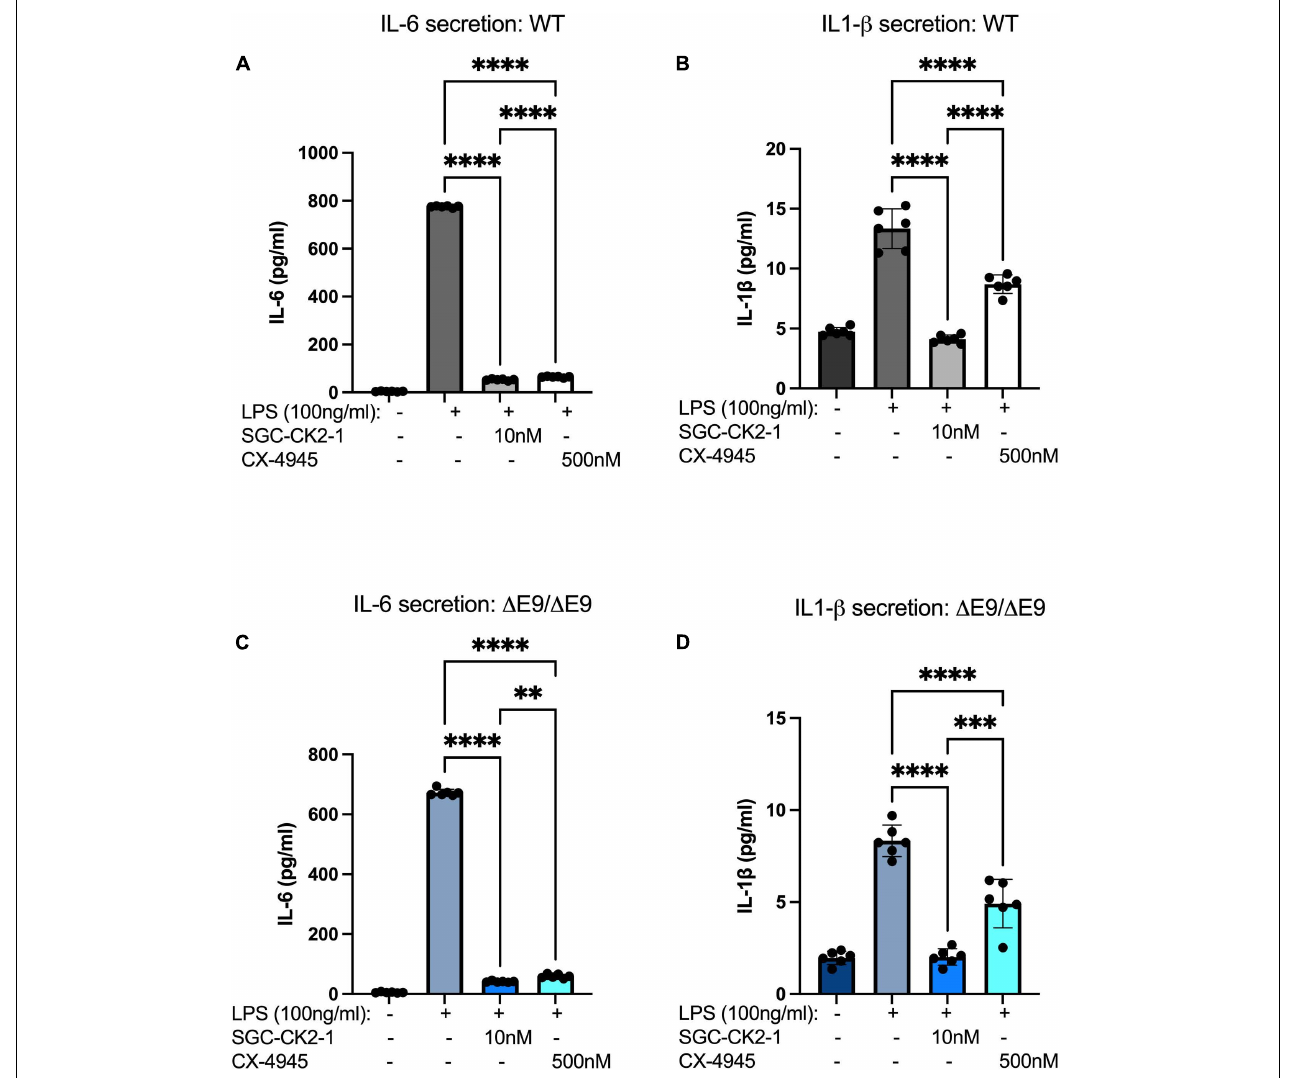
FIGURE 6 | SGC-CK2-1 reduces pro-inflammatory cytokine secretion more effectively than CX-4945. WT (A,B) and FAD (C,D) MGLs were stimulated with LPS and simultaneously treated with either SGC-CK2-1 or CX-4945 for 24 h. In all conditions, SGC-CK2-1 was more effective at inhibiting both IL-6 and IL1- β cytokine secretion into the culture media than CX-4945. These data represent three independent differentiations. ∗∗∗∗ p ≤ 0.0001; ∗∗∗ p = 0.0006; ∗∗ p = 0.0024 by one-way ANOVA analysis. Error bars indicate the mean ±